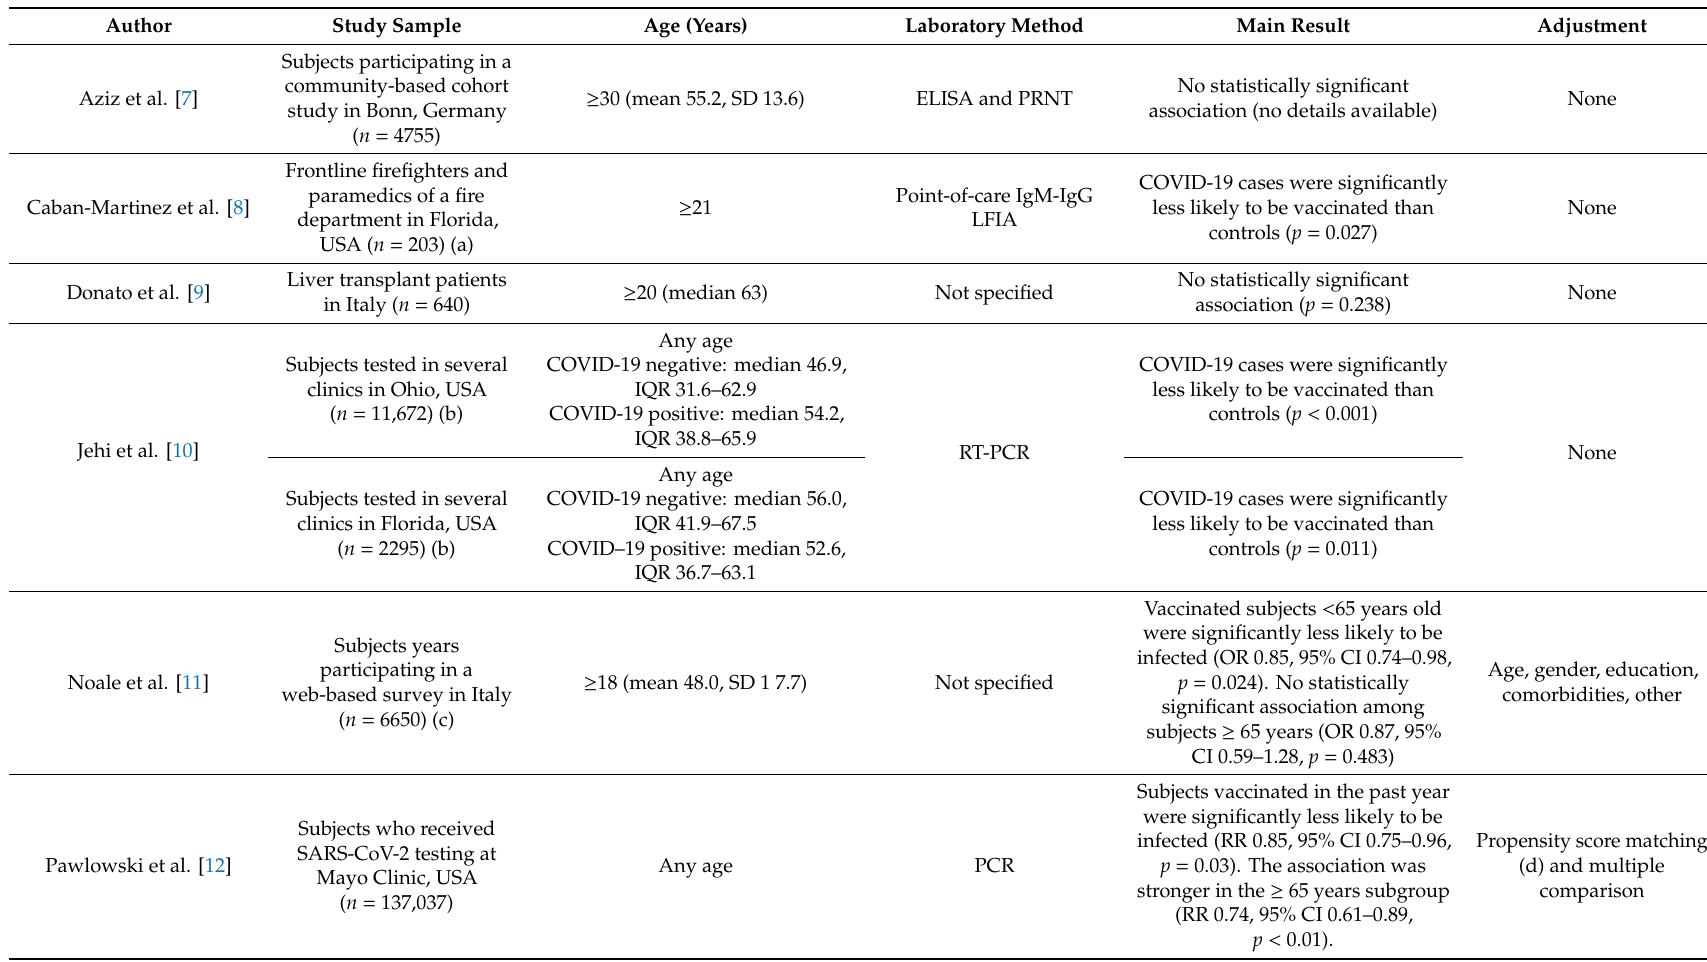
Table 1. Main features and results of studies on the association between influenza vaccination and the risk of infection with